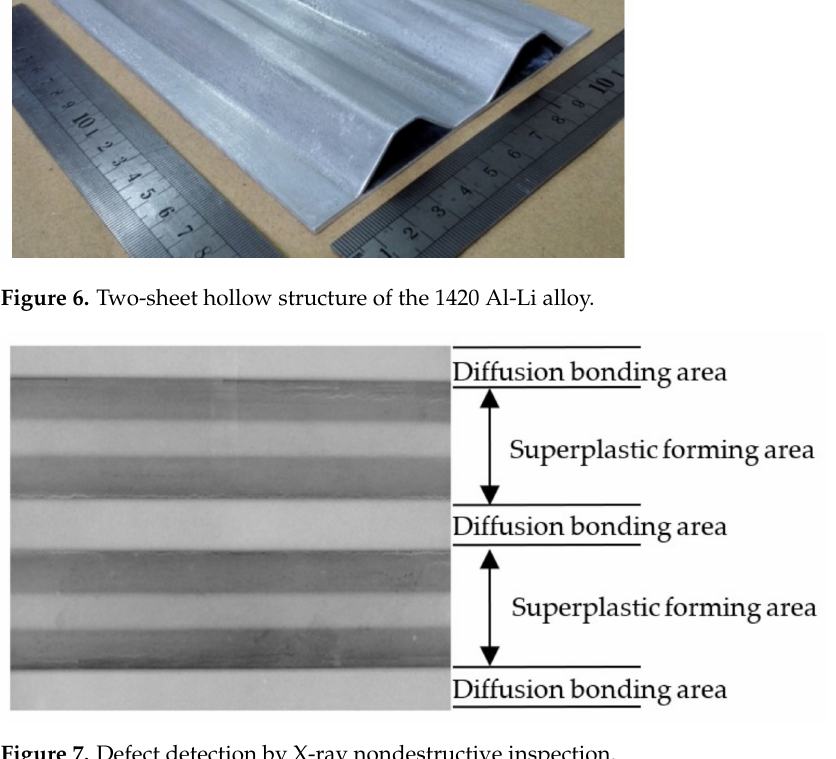
Figure 7. Defect detection by X-ray nondestructive